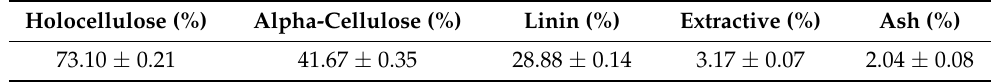
Table 3. Chemical constituents (%) of bamboo fiber.